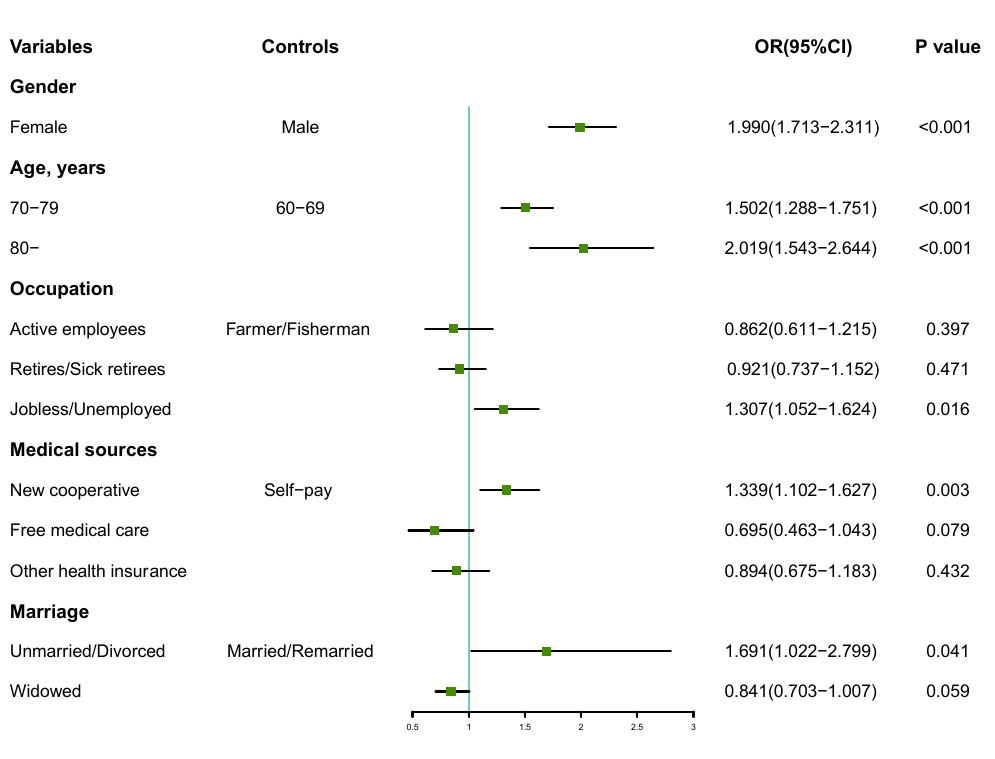
Figure 2. Forest plot of dichotomous multi ‐ factor logistic regression analysis of factors influencing sleep quality among people aged 60 years and above in Shandong province in 2004. OR: odds ratio.